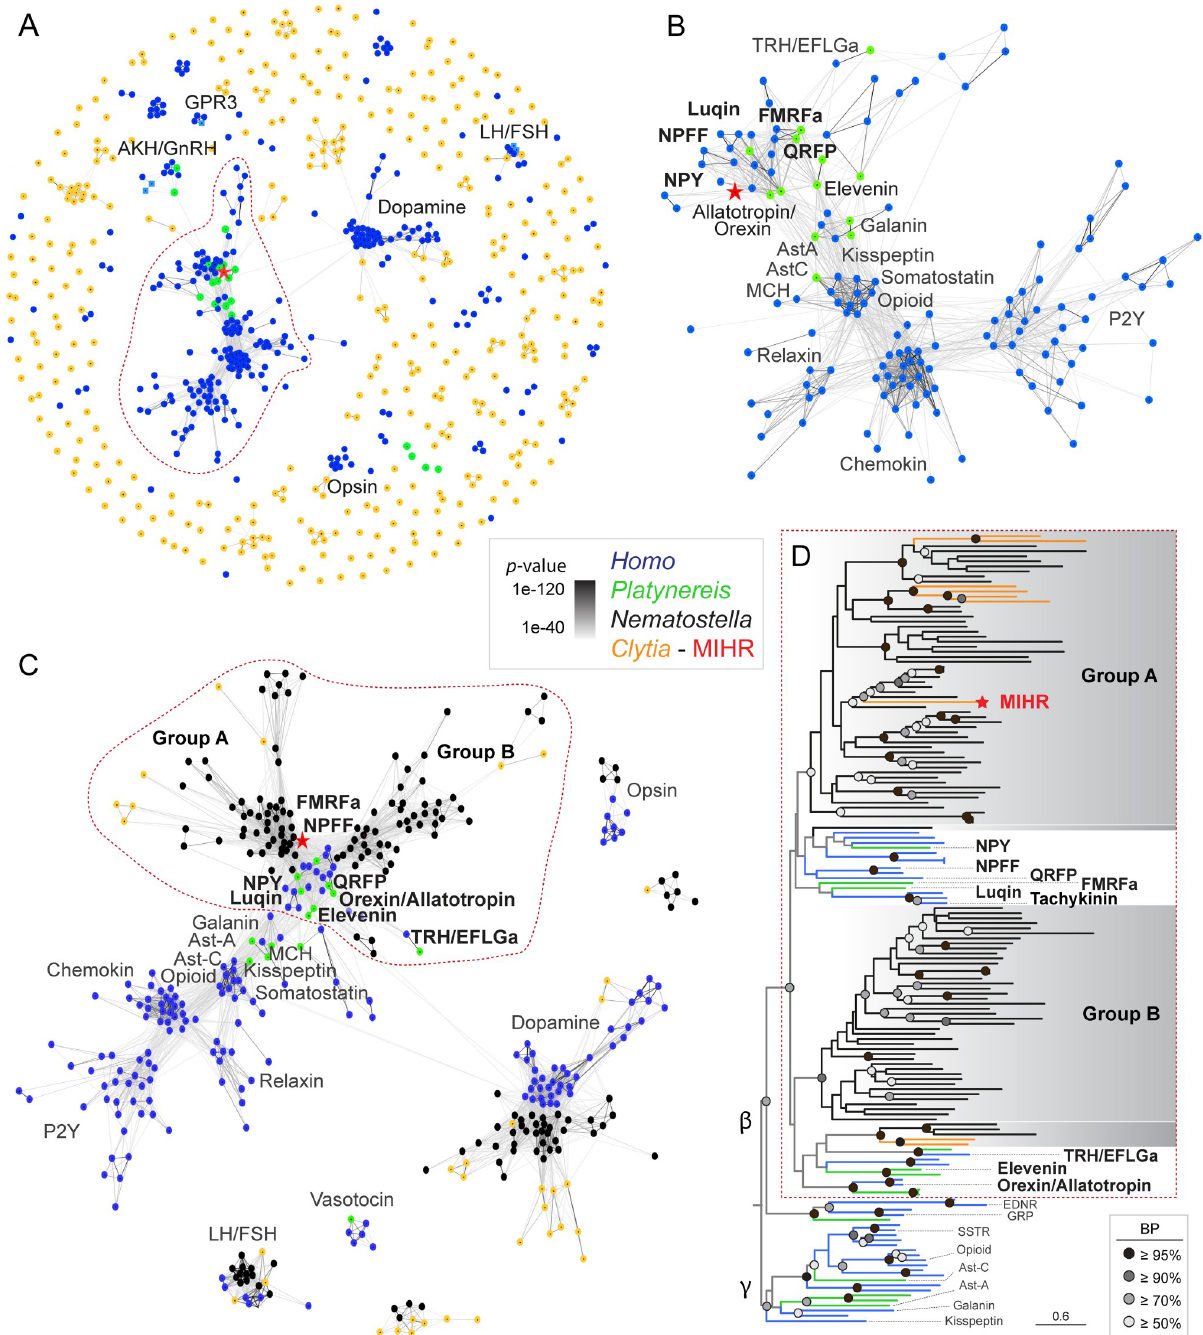
Fig 6. Relationship of Clytia MIHR to bilaterian neuropeptide hormone GPCRs. (A) Sequence-similarity-based clustering using Clans2 of all identified class-A GPCRs from Clytia , human (olfactory receptors excluded), and Platynereis deorphanized GPCRs [28] BLASTP p -value < 1e-40. (B) Cluster map of the largest cluster (circled in red in A), keeping only sequences that show at least 2 connections with the central cluster. BLASTP p - value < 1e-40. (C) More stringent cluster map ( p -value < 1e-50) of the same sequences as in (A) plus all Nematostella GPCR-A sequences. Only clusters containing at least 5 sequences from at least 2 species were kept. All connections with p -value < 1e-40 are shown. (D) Maximum likelihood analysis of the sequences contained inside the dashed area shown in (C) using RaxML (PROTGAMMAGTR) with 500 Bootstrap replicates (BR). Rhodopsin beta GPCRs are rooted against rhodopsin gamma GPCRs [37]. Tree file provided in S2 Fig. Color code: Homo sapiens : blue, Platynereis dumerilli : green, Nematostella vectensis : black, Clytia : orange. Red star: Clytia MIHR. FSH, follicle-stimulating hormone; GnRH, gonadotropin-releasing hormone; GPCR, G protein–coupled receptor; GPR3, G protein–coupled receptor 3; LH, luteinizing hormone; MIHR, MIH receptor; NPY, neuropeptide Y; P2Y, purinoceptor; QRFP, pyroglutamylated RFamide peptide. https://doi.org/10.1371/journal.pbio.3000614.g006 PLOS Biology | https://doi.org/10.1371/journal.pbio.3000614 March 3,